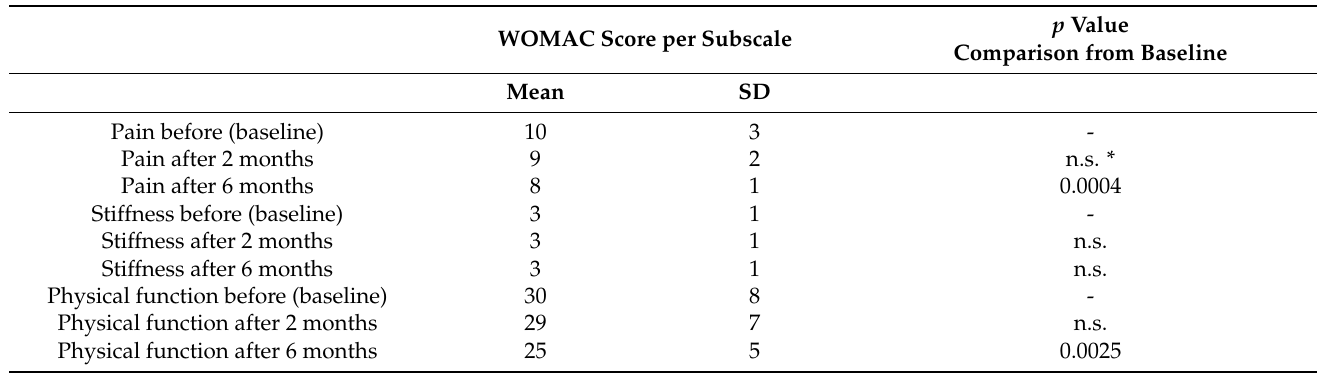
Table 1. Western Ontario and McMaster University Osteoarthritis Index (WOMAC) subscale scores by follow-up time. WOMAC Score per